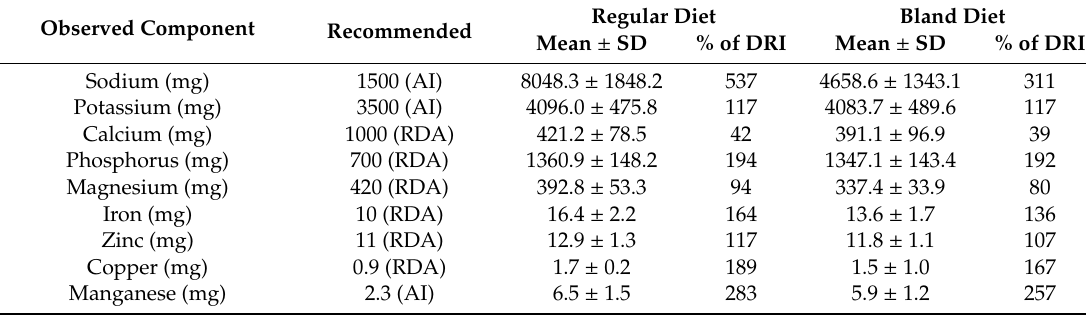
Table 2. Minerals provided in prisons’ ( n = 30) menus per person per day and the age-specific dietary reference intake (DRI).